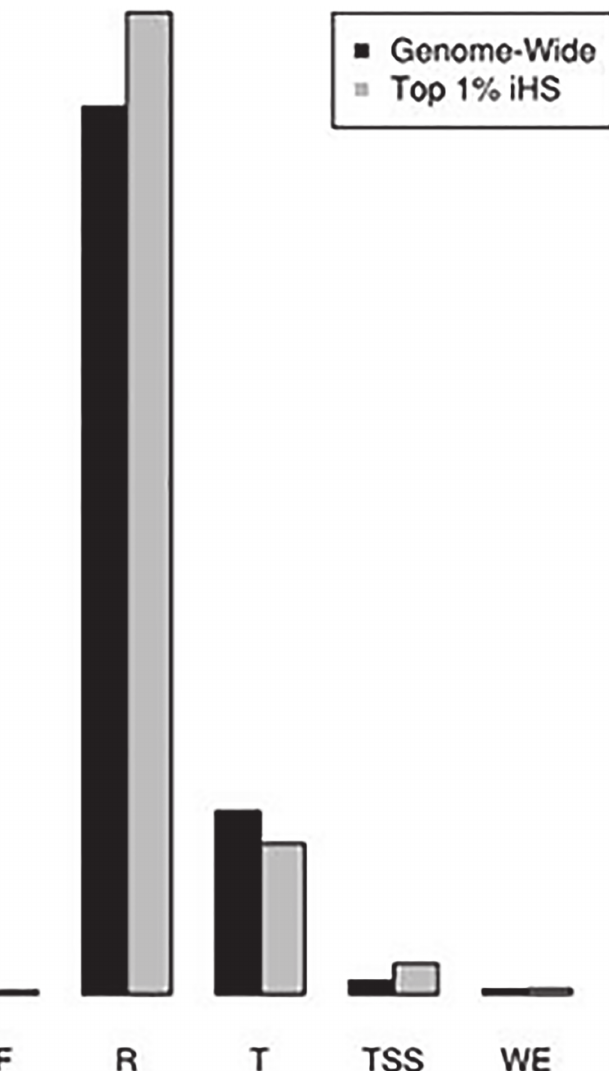
Fig 4. Distribution of ENCODE functional regions genome-wide and in the top 1% of iHS hits. Categories are the 7 identified ENCODE functional regions inferred from the combined ChromHMM and Segway results plus the “ none ” category indicating loci without functional annotation. All categories except for weak enhancers (WE) show significant differences between the two datasets with a P < 0.0063 by a χ 2 test. CTCF: CTCF enriched element; WE: Weak Enhancer; T:Transcribed Region; E: Enhancer; PF:Promoter Flank; R: Repressed/Low Activity; TSS: promoter region including transcription start